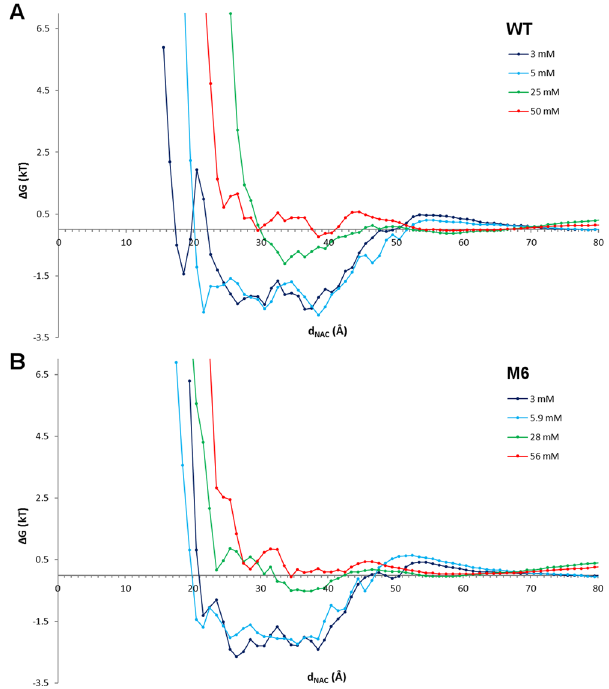
Figure 2. Free energy profile of CPC. Free energies ( Δ G expressed in kT ) calculated for WT ( A ) and M6 ( B ) as a function of the distance d NAC at 4 bulk concentrations of